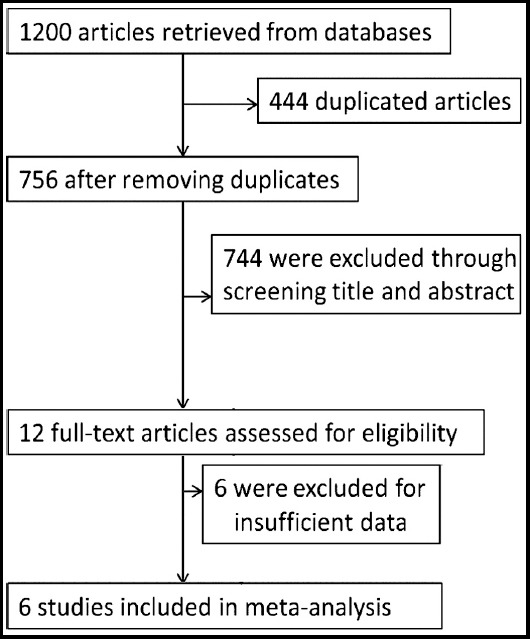
Flow diagram of the study selection process.